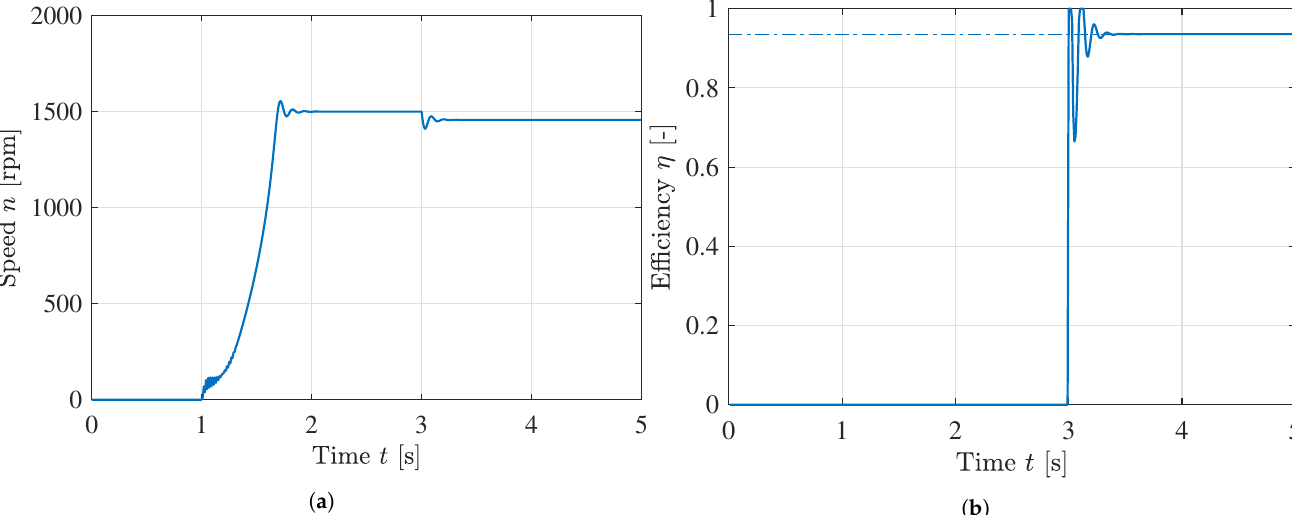
Figure 25. Motor speed and efficiency during startup and full load. ( a ) Motor speed using the estimated parameters; ( b ) Motor efficiency using the estimated parameters (solid line) and motor data (dash-dotted).